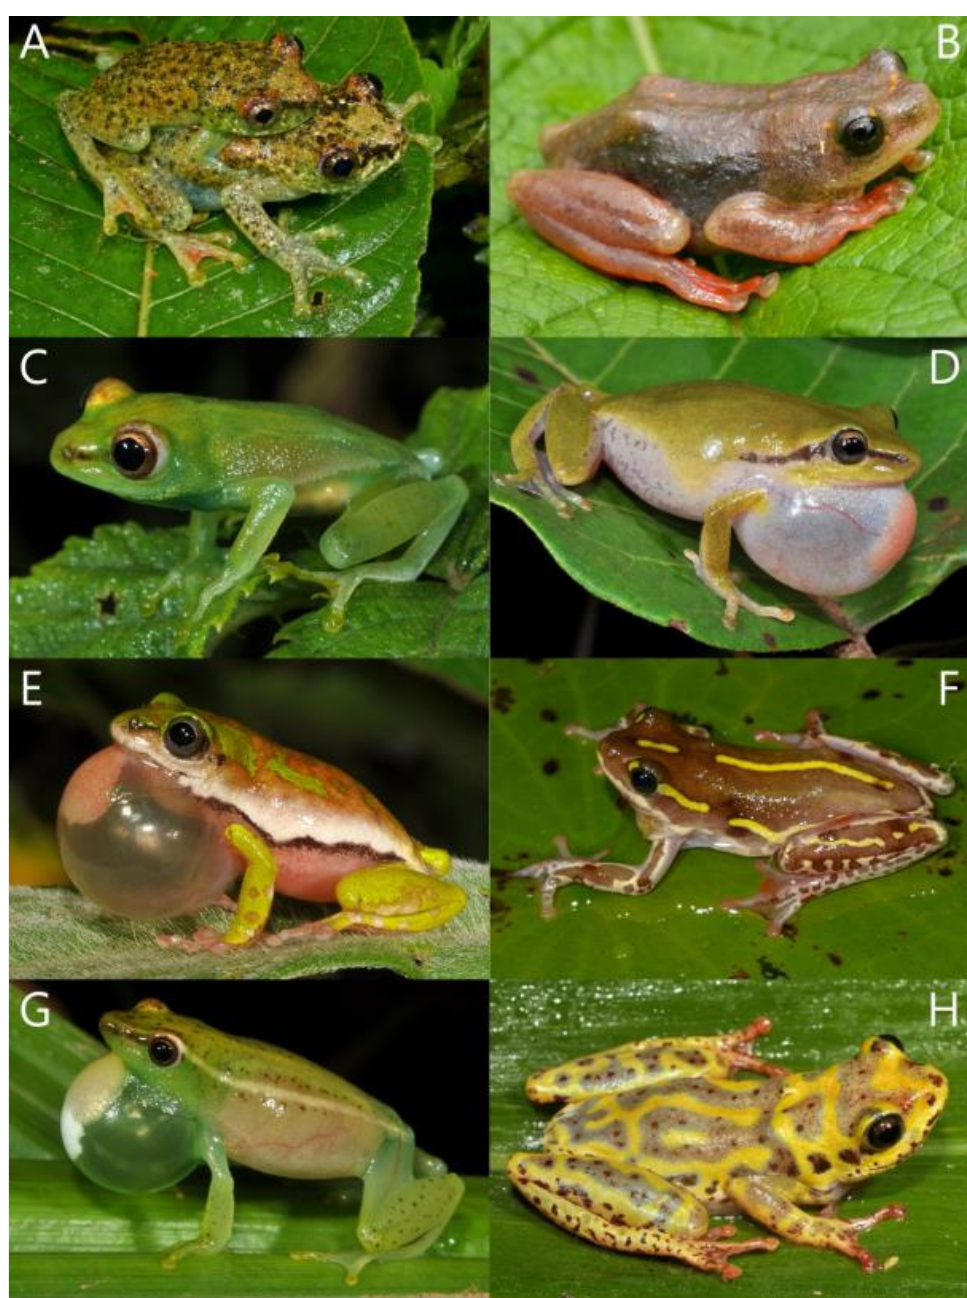
Figure 8. Rwandan species of Hyperoliidae ( A ) Hyperolius frontalis , Nyungwe NP (photo: J.M.D.), ( B ) Hyperolius glandicolor , Volcanoes NP (photo: J.M.D.), ( C ) Hyperolius jackie , Nyungwe NP (photo: JMD), ( D ) Hyperolius kivuensis , Huye (photo: J.M.D.), ( E ) Hyperolius lateralis , Huye (photo: J.M.D.), ( F ) Hyperolius parallelus , Ruzizi (photo: J.M.D.), ( G ) Hyperolius rwandae , Huye (photo: J.M.D.), ( H ) Hyperolius viridiflavus , Kigali (photo: J.M.D.).